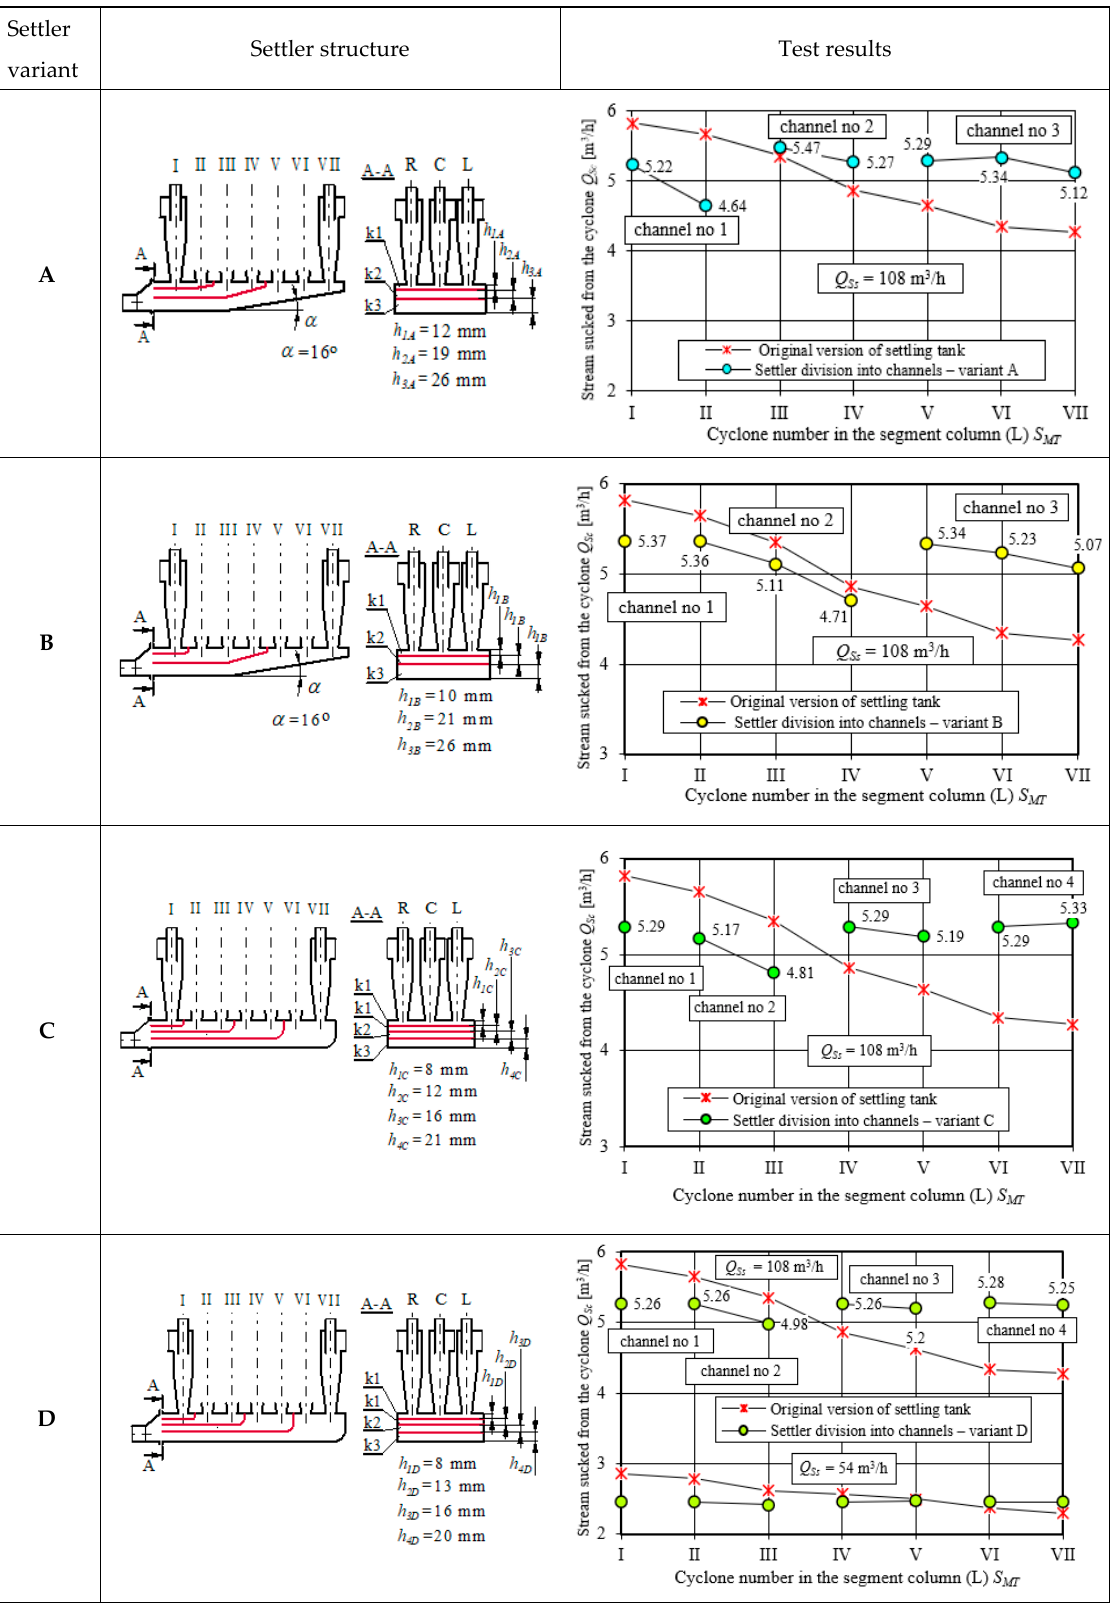
Figure 19. Q Sc suction stream values from individual cyclones from left column (L) of the segment before and after the division of the dust settling chamber into suction channels for variants ( A – D ).